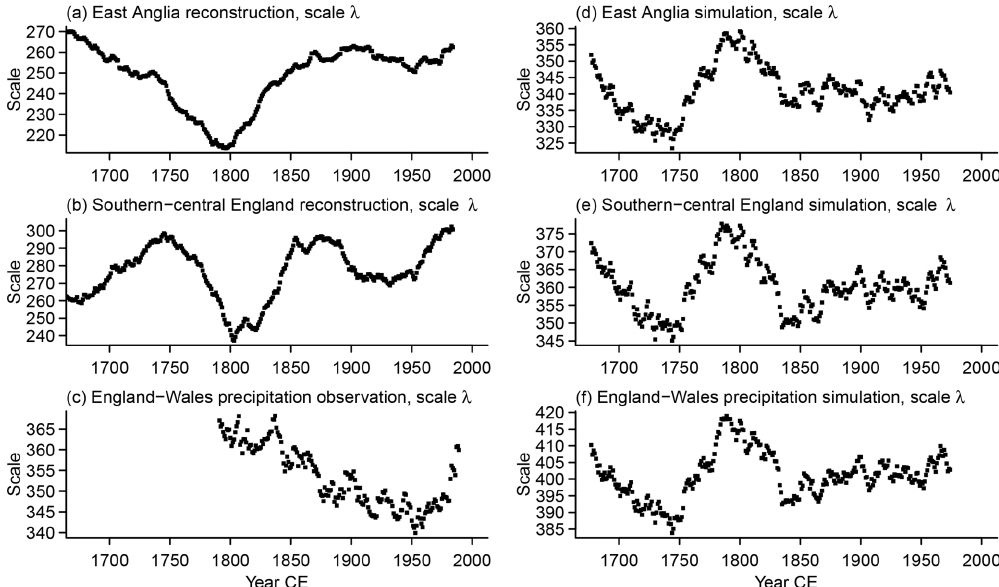
Figure C2. Evolution of the scale parameter λ for the Weibull distribution fits for the (a) East Anglia reconstruction, (b) southern–central England reconstruction, (c) England–Wales precipitation observational data, (d) East Anglia regional simulation, (e) southern–central Eng- land regional simulation, and (f) England–Wales precipitation regional simulation.